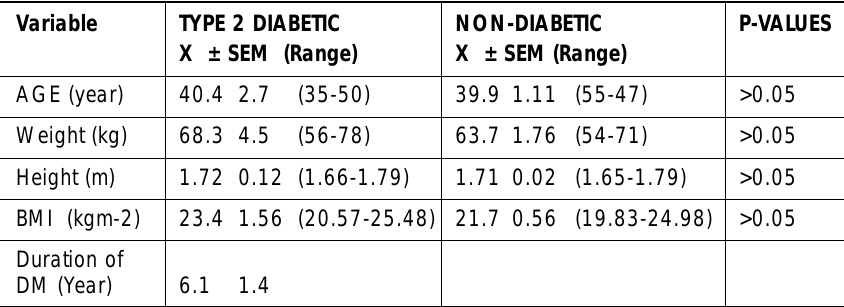
Table 1: Clinical Characteristics of the Subjects